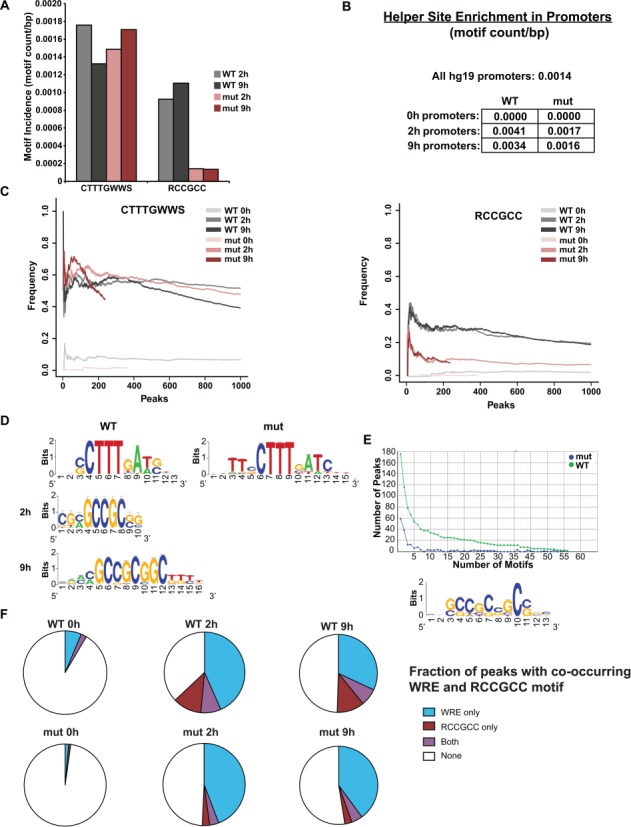
The C-clamp binds to Helper sites on a genome-wide scale. (A) The average motif incidence of the WRE (5′-CTTTGWWS-3′) and the Helper (5′-RCCGCC-3′) in the top 1000 ChIP-seq peaks was calculated by counting the incidence of the motif and dividing by the length of the peak. dnTCF1EWT and dnTCF1Emut had similar enrichment of the WRE. However, dnTCF1EWT had significant enrichment of the Helper site compared to dnTCF1Emut at 2 h (Wilcoxon–Mann–Whitney, P = 8.6E-23) and 9 h (P = 1.9E-10). (B) Helper site enrichment in promoters. The Helper site is found on average 1.4 times per 1000 bp in all human promoters (-1000 bp upstream to 100 bp downstream the TSS). Promoter regions bound by dnTCF1EWT had an enrichment of the Helper site over all human promoters (P = 2.3E-12), whereas dnTCF1Emut-bound promoter regions did not (P = 0.053). (C) Motif frequency of the WRE (left) and the Helper site (right) in dnTCF1EWT and dnTCF1Emut peaks. dnTCF1EWT and dnTCF1Emut peaks had a similar frequency of the WRE, but the Helper site was found in a greater frequency of dnTCF1EWT peaks. (D) RSAT de novo motif enrichment performed on dnTCF1EWT and dnTCF1Emut peaks. The WRE was the top motif found in both dnTCF1EWT and dnTCF1Emut peaks. The Helper site was the fifth most enriched motif at 2 h post-induction and the second most enriched motif at 9 h post-induction. (E) Top graph, the GC-rich motif is enriched in both frequency and copy number of dnTCF1EWT peaks compared to dnTCF1Emut peaks. A full display of de novo motif enrichment results is found in Supplementary Figures S4–S6. Bottom panel, the most enriched motif from RSAT differential de novo motif analysis which uses dnTCF1Emut ChIP-seq peaks as a background to find motifs that are comparably enriched in dnTCF1EWT peaks. (F) Fraction of the top 1000 ChIP-seq peaks with the indicated motifs.